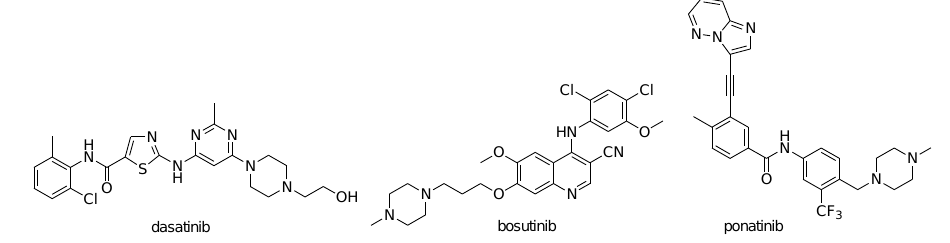
Figure 1. Structures of approved SFK inhibitors dasatinib, bosutinib, and ponatinib.